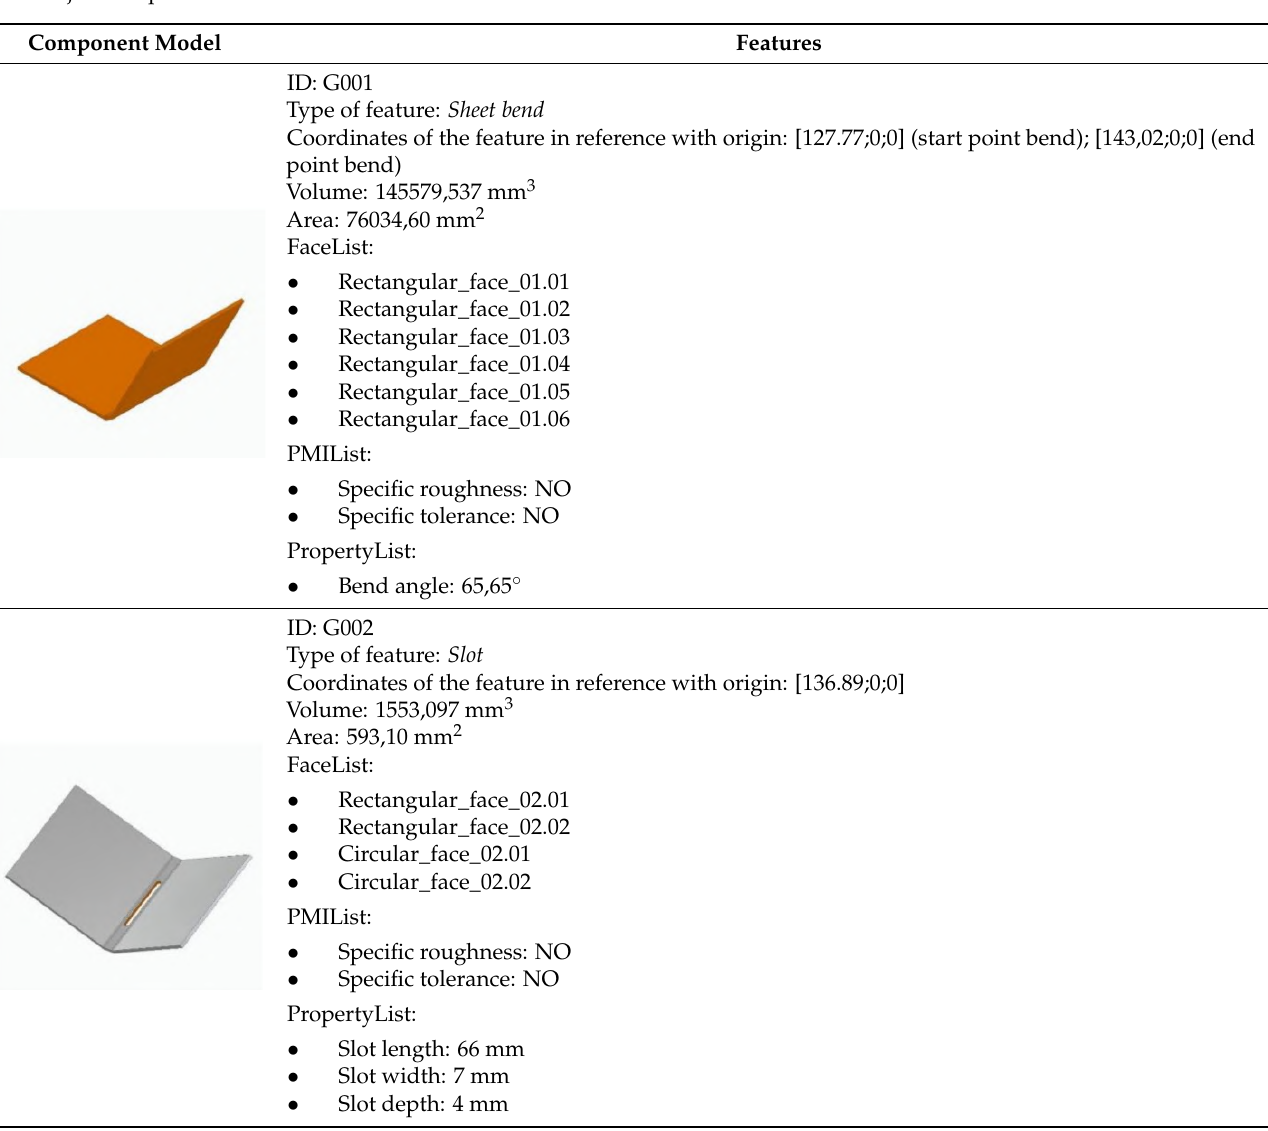
Table 3. Example of geometric features (highlighted in orange) extracted by the 3D CAD model of the C002 component of the jack adapter.